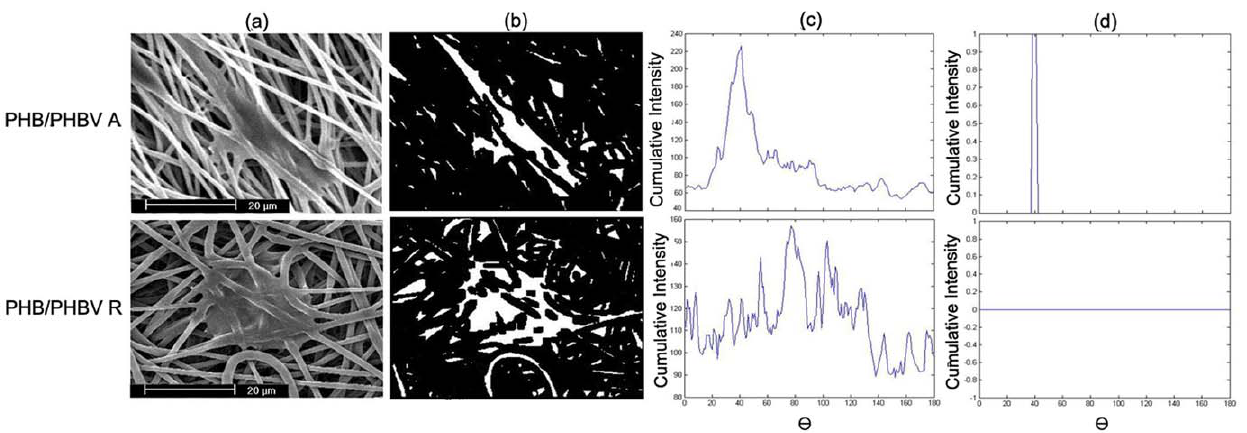
Figure 6. Image processing algorithms on SEM images of cultured SCs on PHB(50)/PHBV(50) random (PHB/PHBV R group) and PHB(50)/PHBV(50) aligned (PHB/PHBV A group) nanofibrous scaffolds. (A) Original SEM image of SCs on scaffold after 1 day of cell culture; (B) binary image showing the processing output of nonlinear diffusion filtering; (C) Radon transform results of binary image for a range of [0,180 u ] and with a resolution of Dh =1 u ; (D) dominant peak of the maximum of Radon transform matrix.